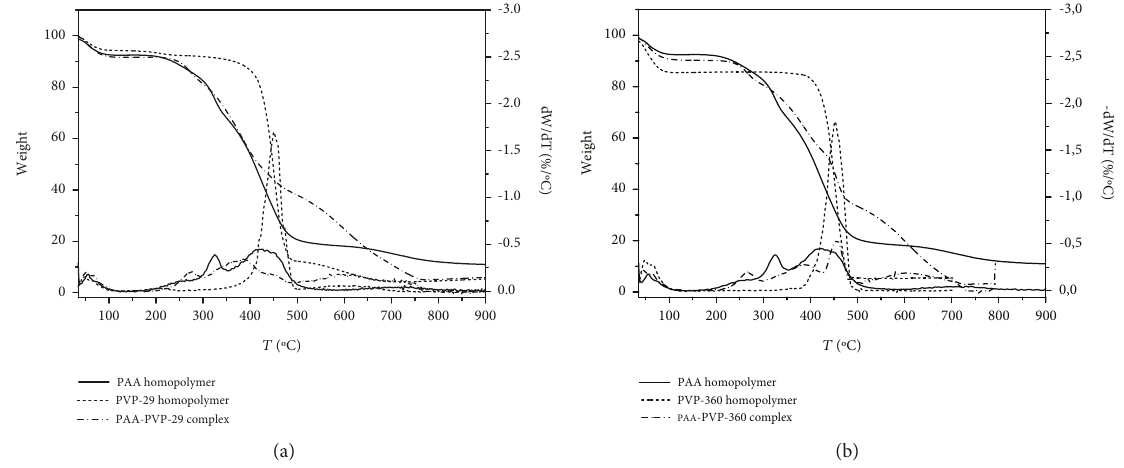
Figure 4: TGA thermograms of PAA, PVP, and the PAA-PVP complexes: (a) PVP-29 and (b)